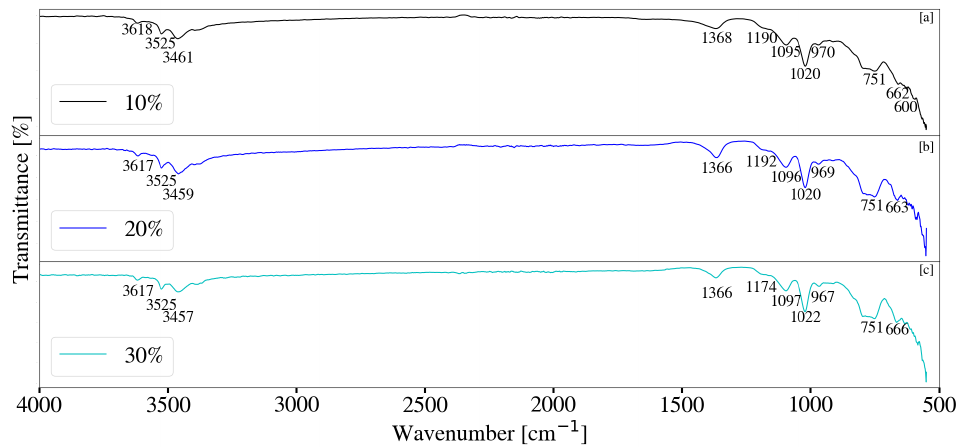
Figure 18. ( a ) FT-IR analysis for Mg-Al LDH sample synthesised with a 10% solids loading (S2). ( b ) FT-IR analysis for Mg-Al LDH sample synthesised with a 20% solids loading (S7). ( c ) FT-IR analysis for Mg-Al LDH sample synthesised with a 30% solids loading (S8). Milling parameters were